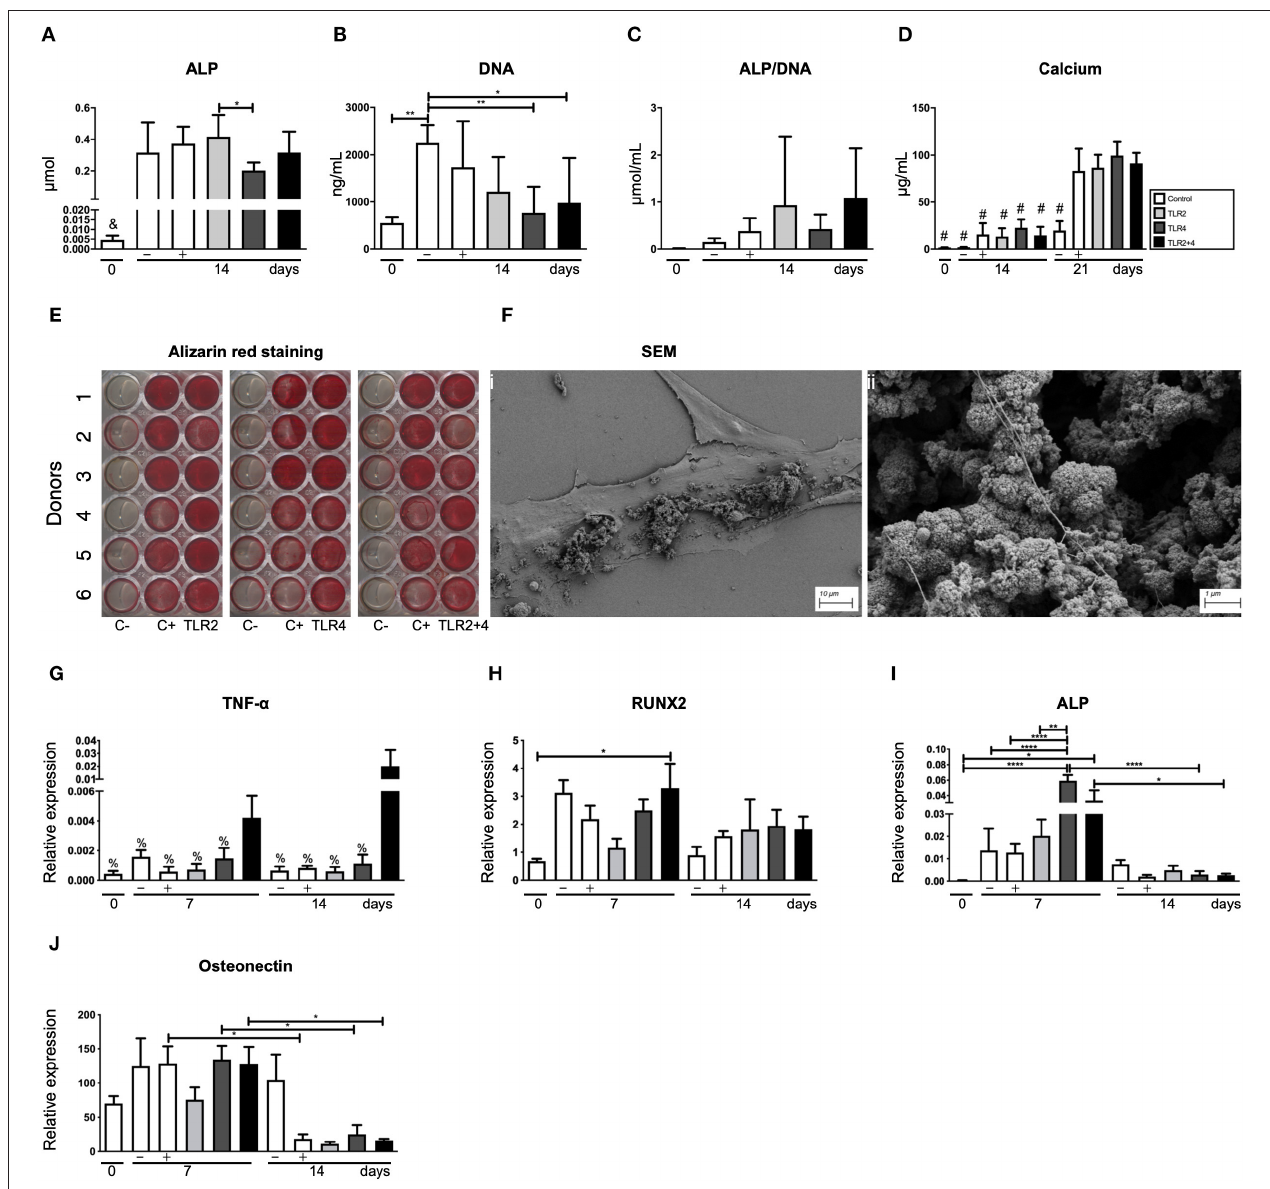
FIGURE 6 | TLR agonists do not affect the osteogenic capacity of gingival fibroblasts. (A) Alkaline phosphatase (ALP), (B) DNA, (C) alkaline phosphatase corrected per number of cells (ALP/DNA), and (D) calcium deposition were quantified. (B) Compared to control cultures, TLR4 agonist (alone or with TLR2) affected the proliferation of cells. Overall, no significant differences were observed between the control conditions and the TLR agonists for (A) ALP, (C) Calcium deposition, and (E) Alizarin red staining. Alizarin red staining was done using control conditions without (C–) or with (C + ) mineralization medium. The staining showed heterogeneity between the 6 donors. (F i ) Shows the osteogenic matrix under scan electron microscopy and (F ii ) presents structures that resemble mineral nodules. (G–J) Present the results of the quantitative PCR. (G) TNF- α is positively mediated by the combination of TLR2 + 4 at early and late time points (day 7 and 14). (H) RUNX2 is only increased at day 7 by the combination of TLR2 + 4, in comparison with the baseline (day 0). (I) Expression of the ALP gene is elevated in all conditions at day 7 in comparison with the baseline (day 0). TLR4 is also elevated compared to the negative and positive controls at day 7 and compared to the TLR4 at day 14. TLR2 + 4 reduced significantly from day to day 14. (J) Osteonectin gene expression reduced significantly from day 7 to day 14 for the control, TLR4 and TLR2 + 4. n = 6 per condition in duplicates, average results ± SD are shown. Significant results for (A–D) and (G–H) are shown (black bars). * p < 0.05, ** p < 0.01, *** p < 0.001, **** p < 0.0001 in comparison to all the other conditions, # p < 0.0001 in comparison to the c ( + ), TLR2, TLR4, and TLR2 + 4 at day 21, % p < 0.001 in comparison to TLR2 + 4 at day